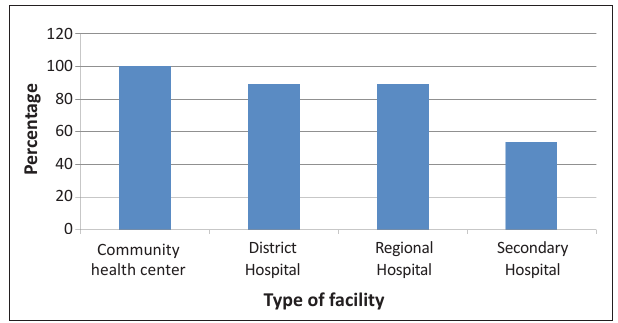
FIGURE 2 : Perception of the usefulness of Telemedicine according to place of work of health care